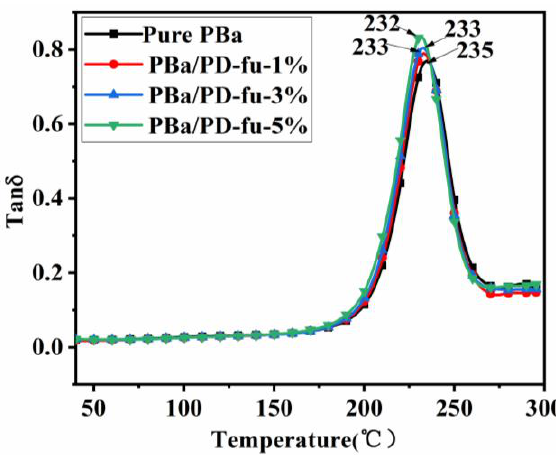
Figure 14. Tan δ vs. temperature curves of neat PBa, PBa/PD-fu-1%, PBa/PD-fu-3% and